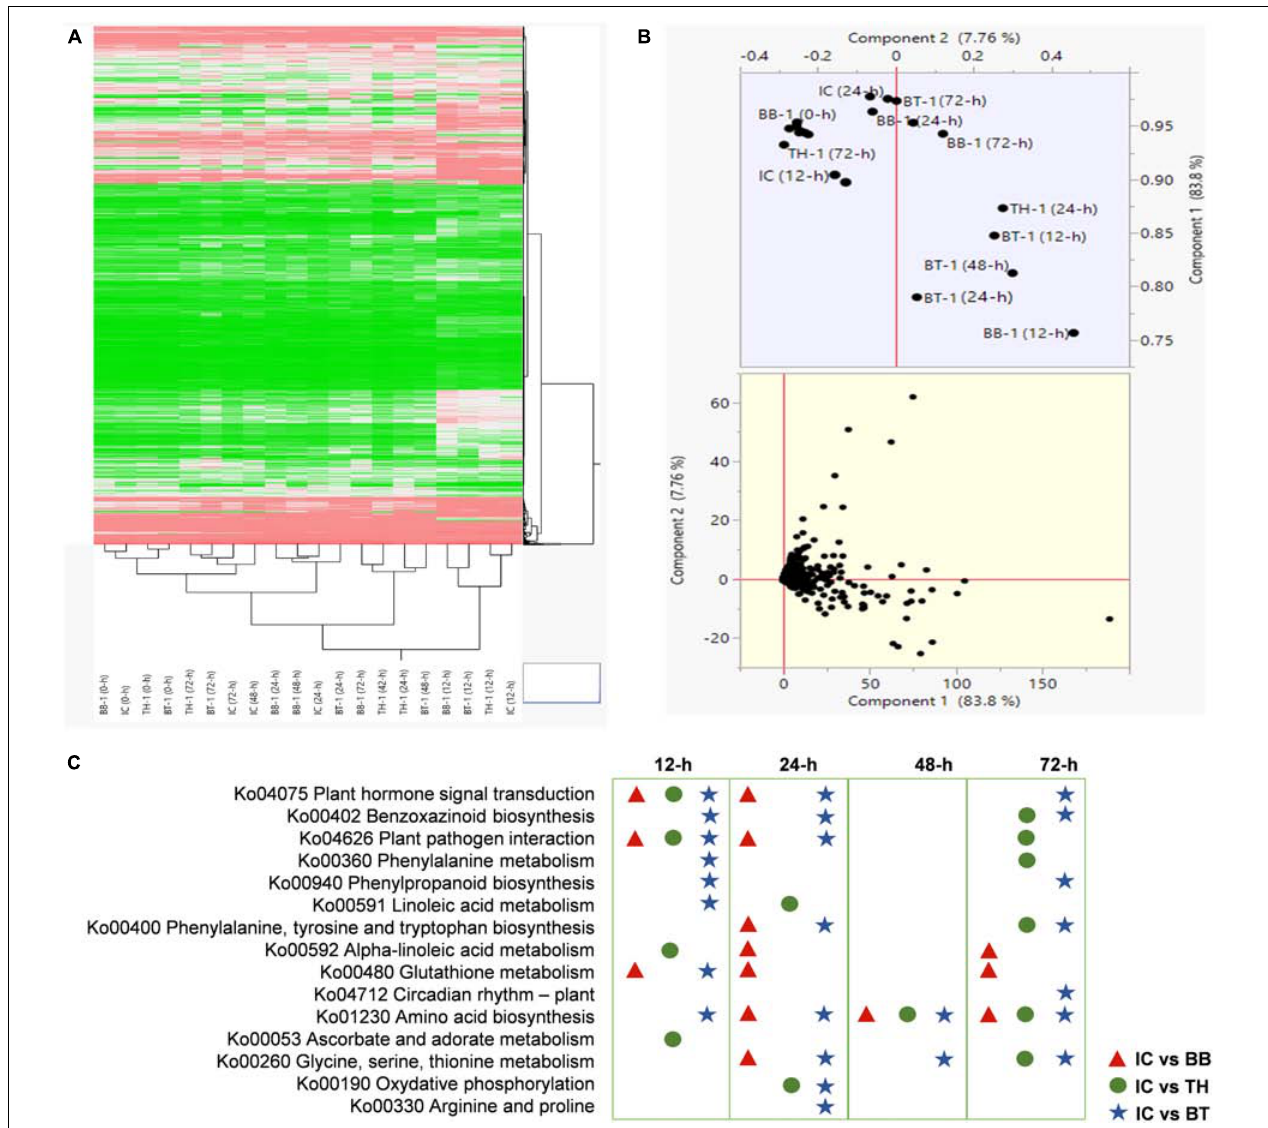
FIGURE 3 | Transcriptome response of maize inoculated with single and consortium of Beauveria bassiana OFDH1-5 and Trichoderma asperellum GDFS1009 to Ostrinia furnacalis . (A) Hierarchical Cluster dendrogram of differentially expressed genes, the difference in color indicate high (red) and low (green) expression. (B) PCA plot showing variability of transcriptome data; (C) top enriched resistance related pathways in IC vs. BB, IC vs. TH, IC vs. BT at 12-, 24-, 48-, and